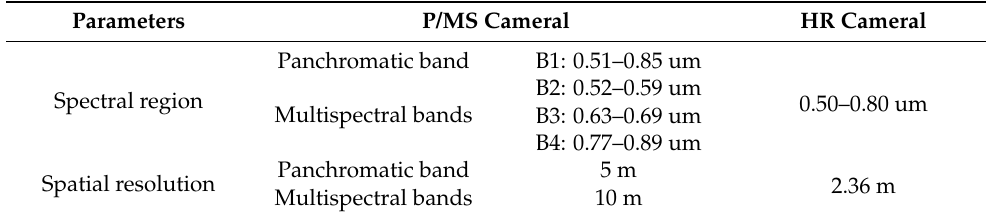
Table 1. Band parameters of the ZY-1-02C